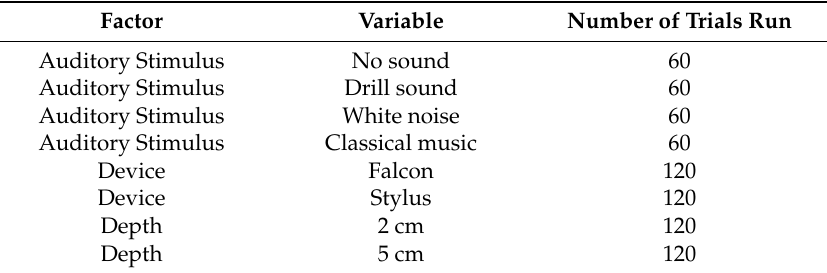
Table 1. Between-subject factors by device.